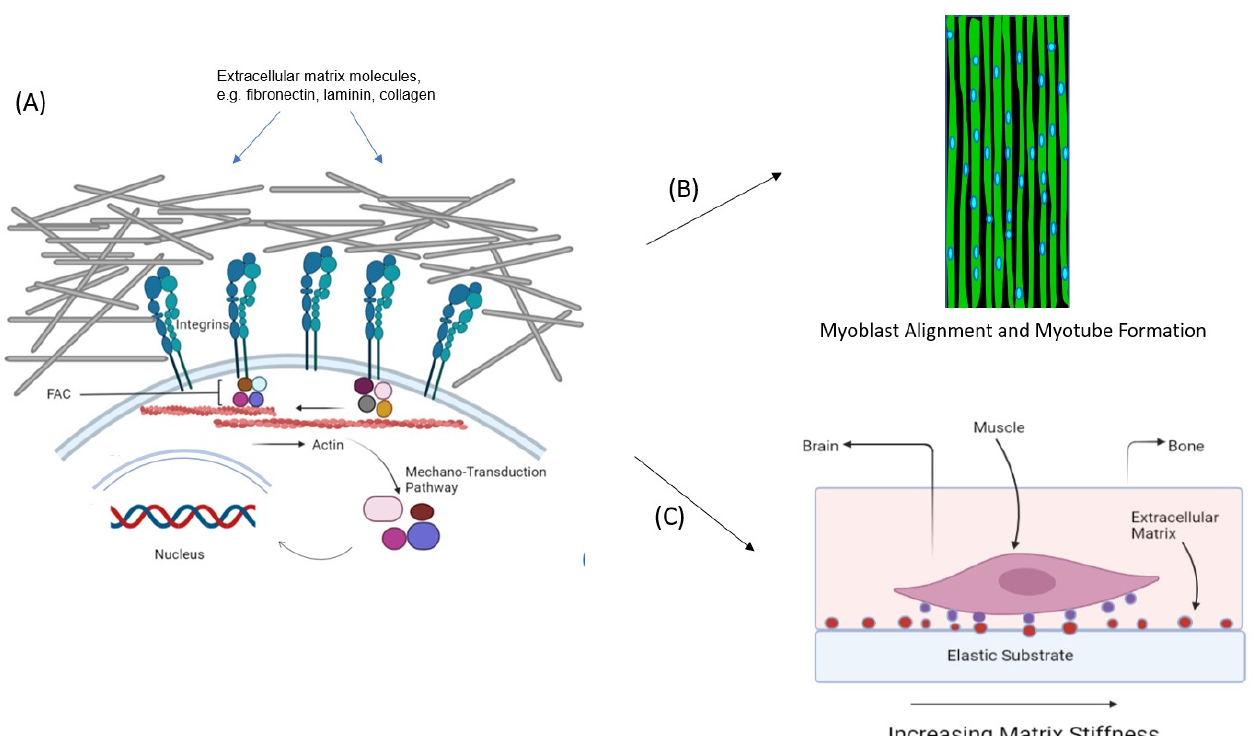
Figure 2. ( A ) Muscle cell adhesion is mediated by integrin receptors on the cell membrane, which bind to ligands present in the extracellular matrix. This results in signaling via the mechanotransduction pathway, which leads to changes in gene expression and the modification of the cell phenotype. Cell adhesion is important for two reasons: ( B ) it enables myoblasts to follow geometrical cues, leading to their alignment as well as myotube and myofiber formation; ( C ) it allows stem cells to sense the mechanical properties of the underlying substrate and differentiate accordingly into specific tissue lineages. Mesenchymal stem cells have been shown to differentiate into the muscle lineage when cultured on polyacrylamide substrates with elastic moduli ranging between 8–17 kPa.